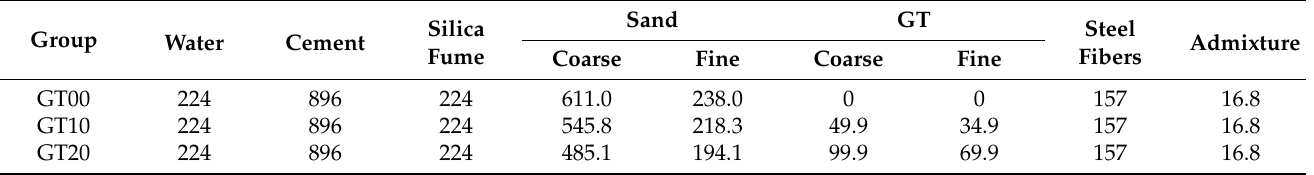
Table 9. Concrete mixture proportion of GT00 to GT20 (kg/m 3